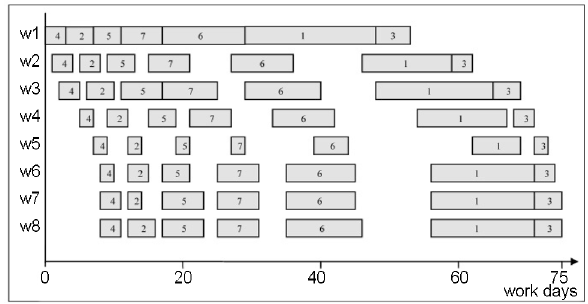
Fig. 8. Building schedule for individual road segments for the permutation obtained by the tabu search